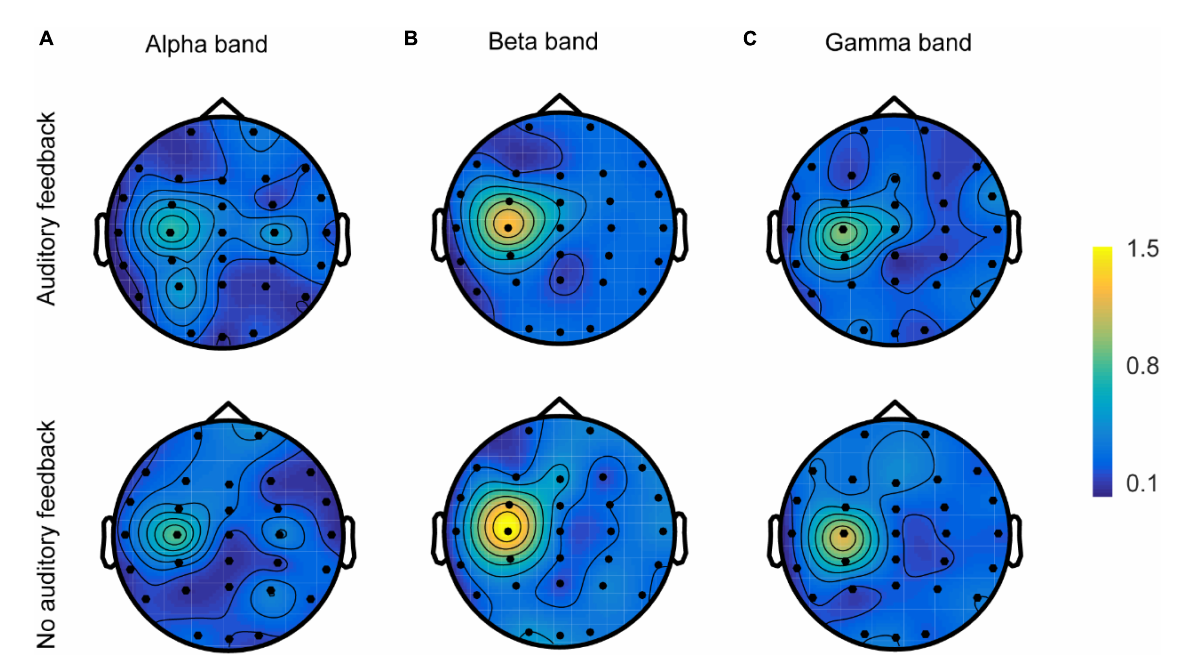
FIGURE8 The spatial topologies of CMC of all the participants ( N = 17) in the alpha band (A) , the beta band (B) , and the gamma band (C) in auditory feedback condition and no auditory feedback condition. CMC, corticomuscular